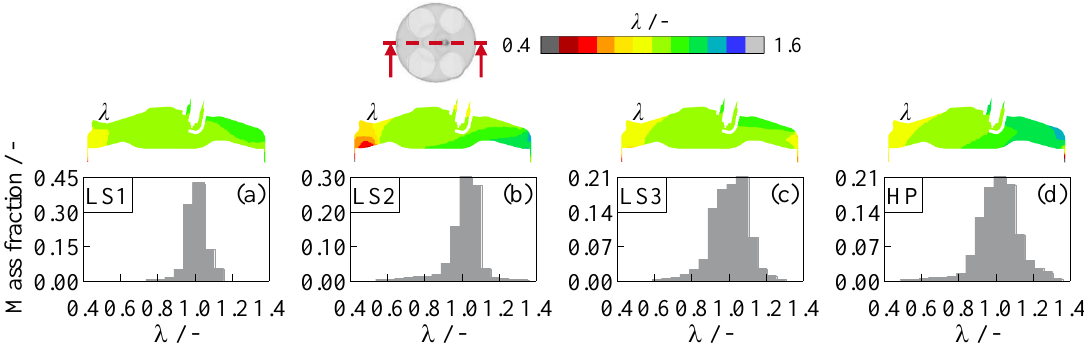
Figure 4. Lambda distribution for all the operating points at 20 ◦ CA before TDC F : mass fraction distribution over λ -bins and central section of the combustion chamber. Operating points: ( a ) LS1, ( b ) LS2, ( c ) LS3, ( d ) HP.